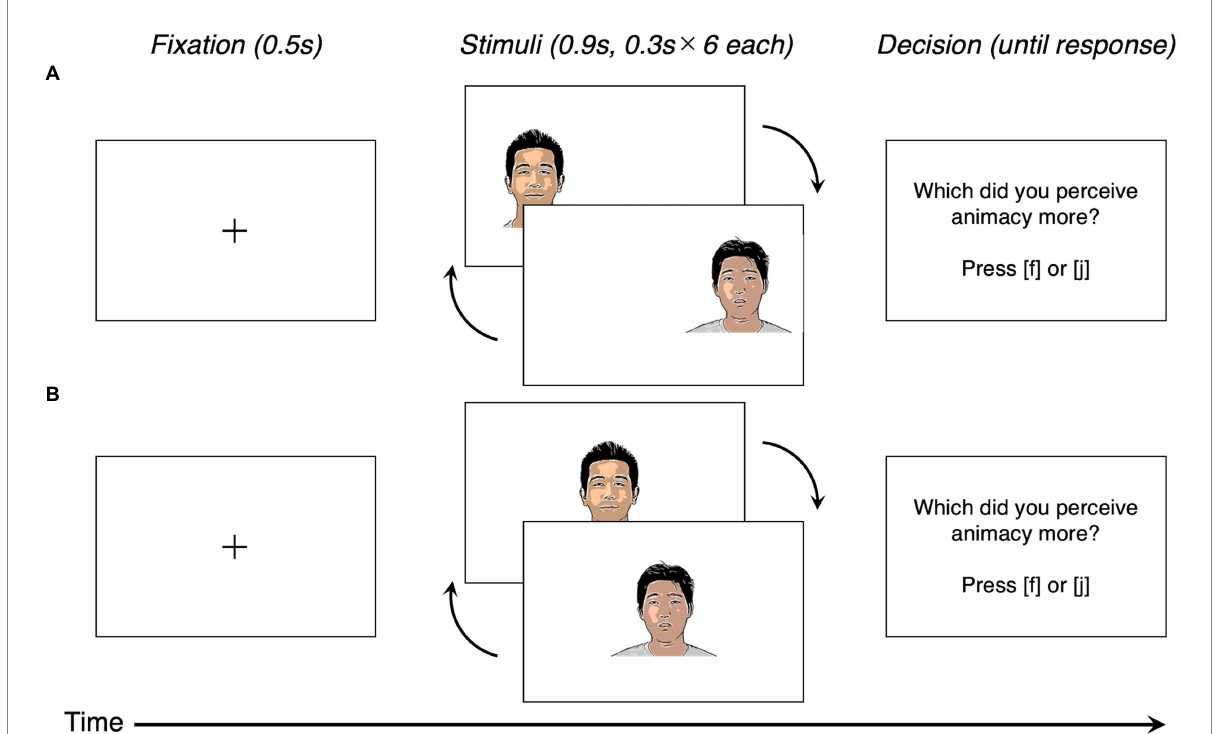
FIGURE 2 Example of task flow in Studies 1a to 1c and Study 2. Note. In Studies 1b, 1c, and 2, the instruction for decision-making was changed depending on the conditions [which did you prefer?] for Study 1b; and which did you perceive as rounder?; for Studies 1c and 2. (A) the arbitrary eye movement condition in Studies 1a-1c, 2 and (B) the fixed eye movement condition in Study 2. Adapted with permission from Chicago Face Database, available at https://www.chicagofaces.org/ (Ma et al.,